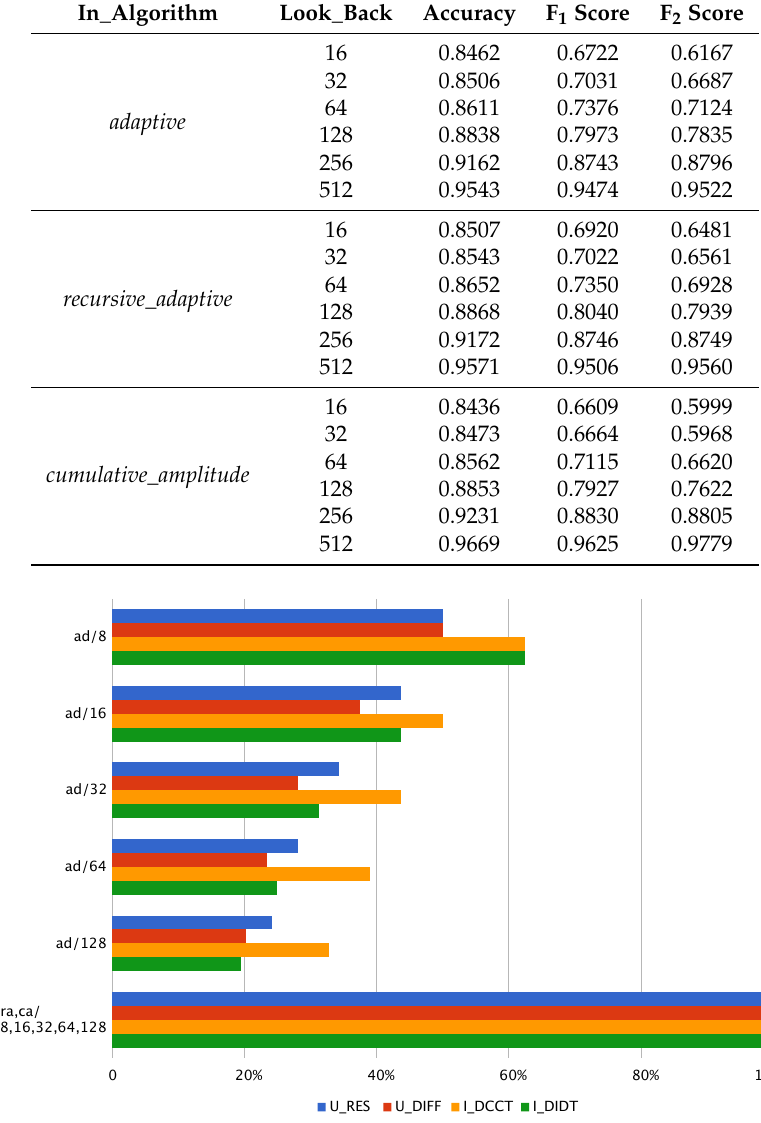
Figure 11. Grid use for various in _ grid values and in _ algorithm . ad— adaptive , ra— recursive_adaptive , ca— cumulative_amplitude